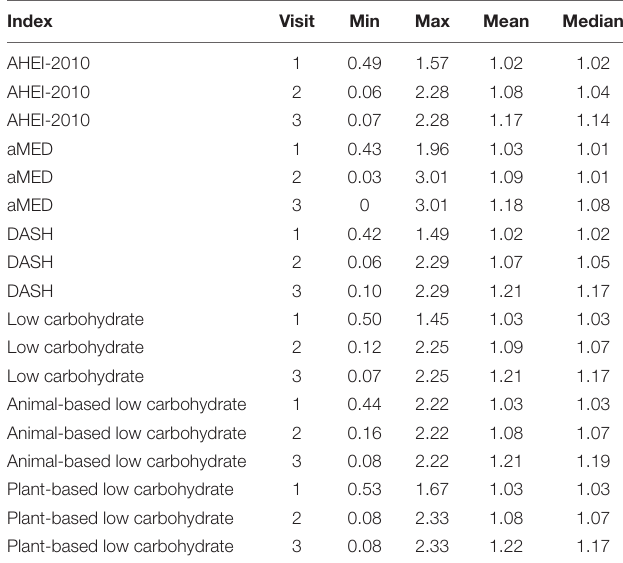
TABLE 2 | Descriptive statistics for stabilized weights computed using weight